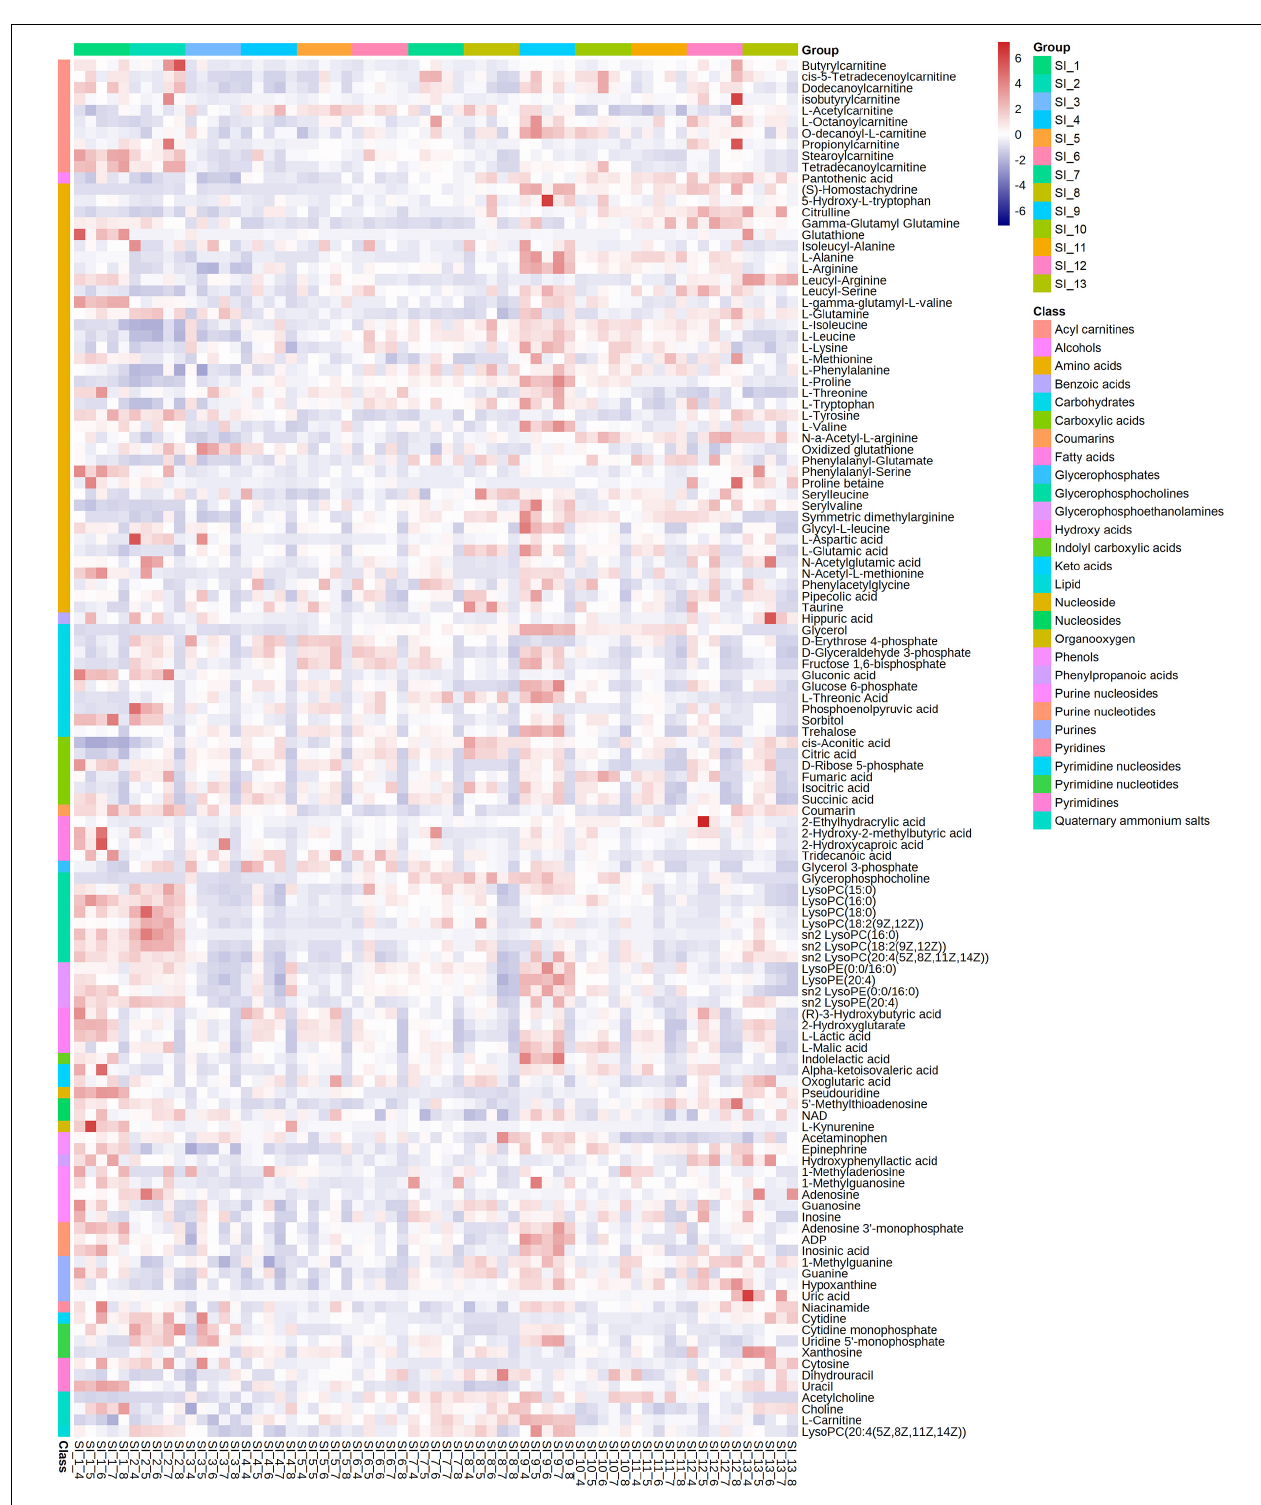
Frontiers in Physiology |